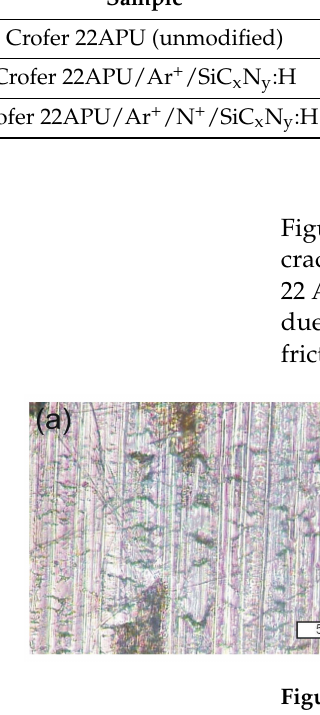
Figure 6. Images of the wear track of the samples after the ball-on-disc test: with SiC x N y :H layer,1 N- 1500 cycles ( a ), after N + ion modification and SiC x N y :H layer, 0.5 N-180 cycles ( b ) and unmodified Crofer 22APU steel ( c